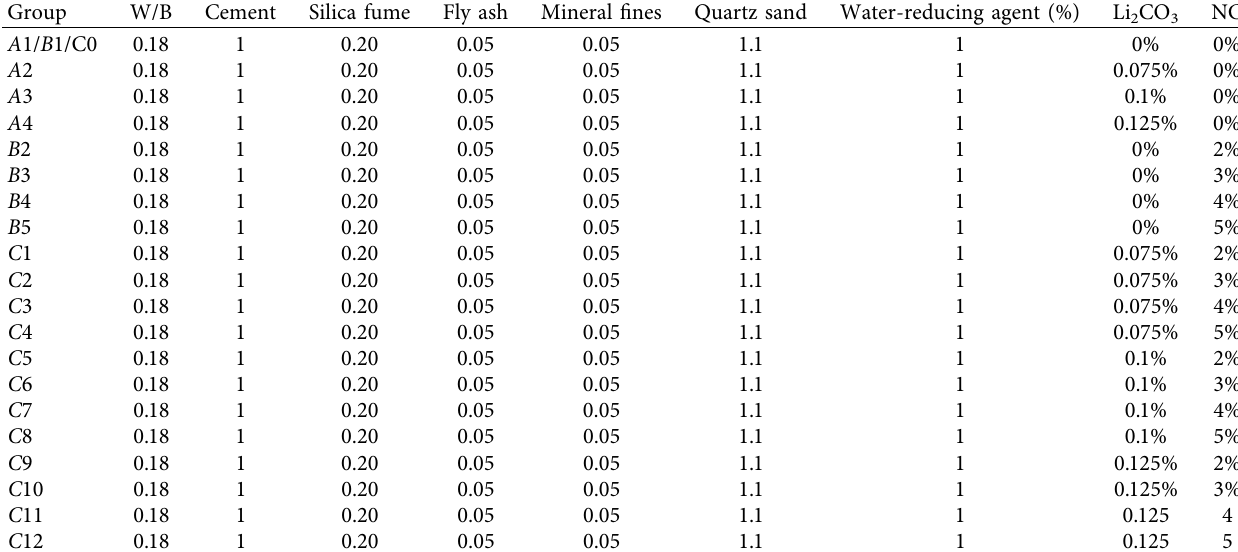
Table 5: Basic mix design of high early strength